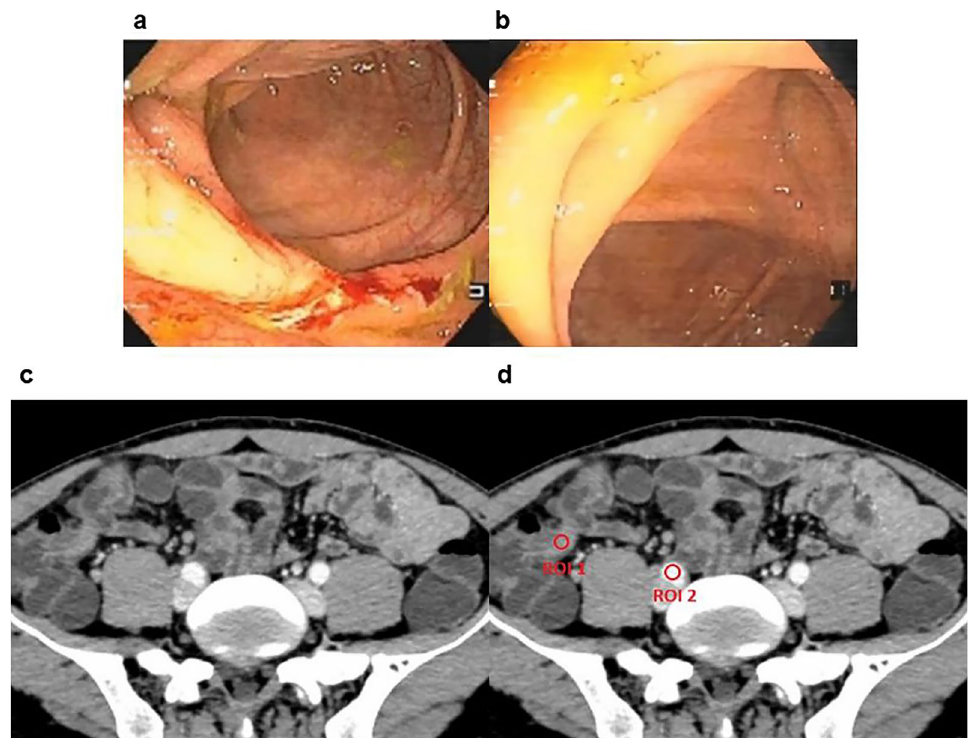
Fig. 3 A 39-year-old man with Crohn’s disease achieved endoscopic mucosal healing after 6 months of therapy. a Endoscopic images of the terminal ileum show ulcerating inflammation before infliximab treatment. b Posttreatment endoscopic images show mucosal healing. c On the posttreatment enteric phase axial CTE image, the wall of the terminal ileum is thickened. d ROI1 was placed in the thickened wall of the terminal ileum in these iodine-based material decomposition images, and ROI2 was placed in the iliac artery at the same level. The NIC in this thickened wall of the terminal ileum was